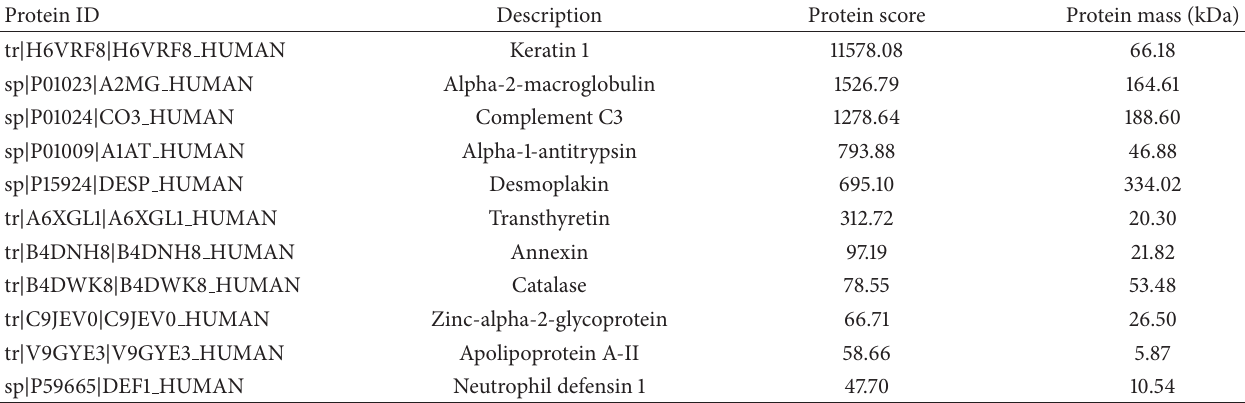
Table 2: The proteins with high score derived from the mass spectrometry analysis.